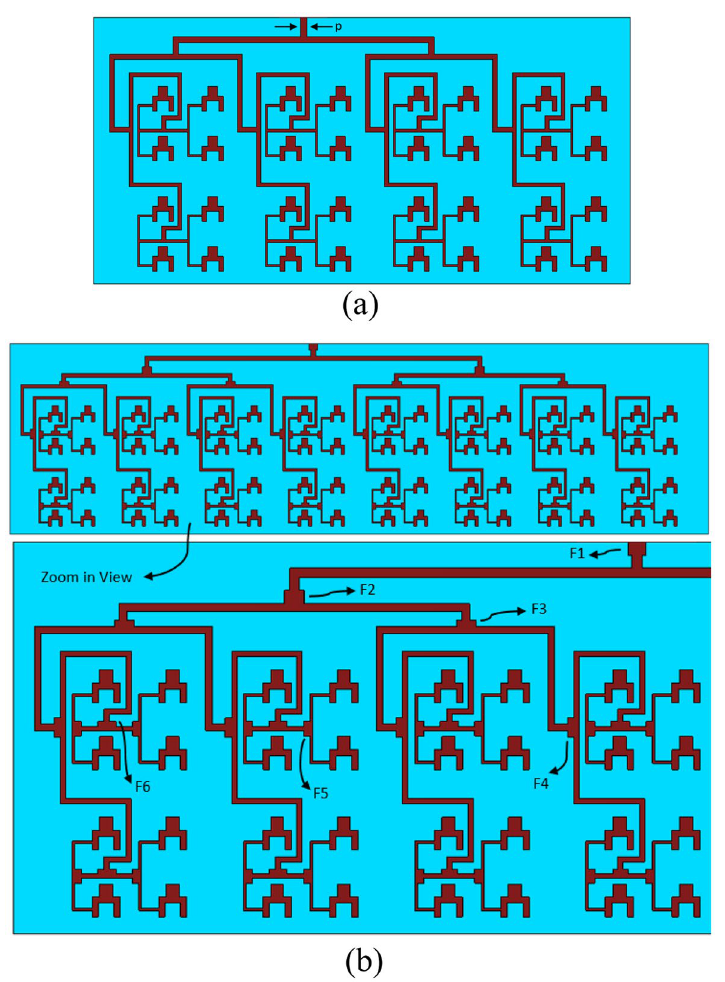
Figure 3. Geometry of the proposed antenna array, ( a ) 8 × 16, and ( b ) 8 × 32.